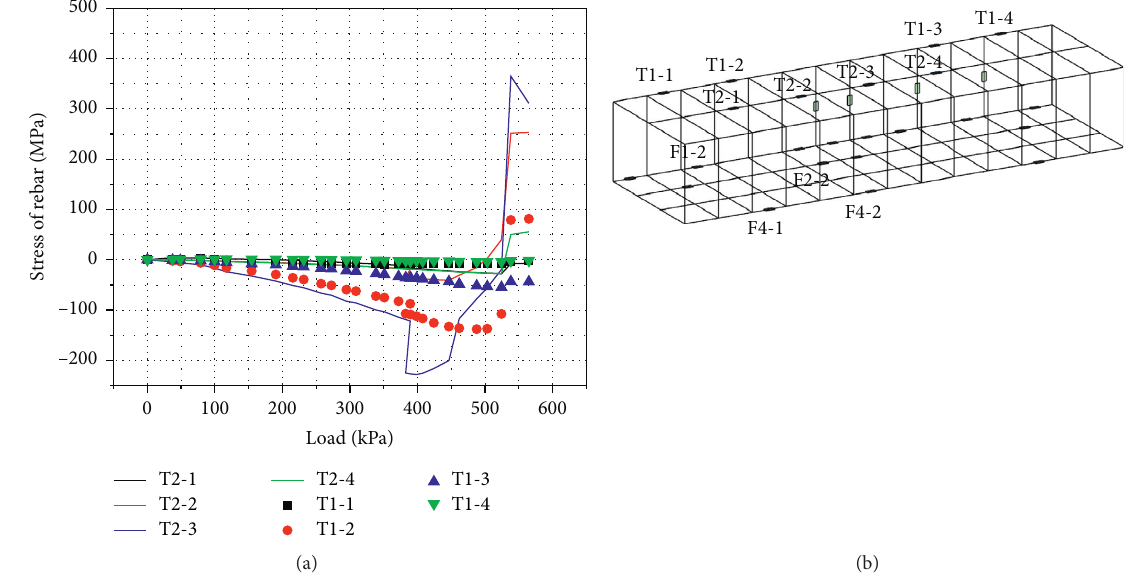
Figure 12: Stress evolution of B1. (a) Load-stress curve of top rebars. (b) Measuring points of